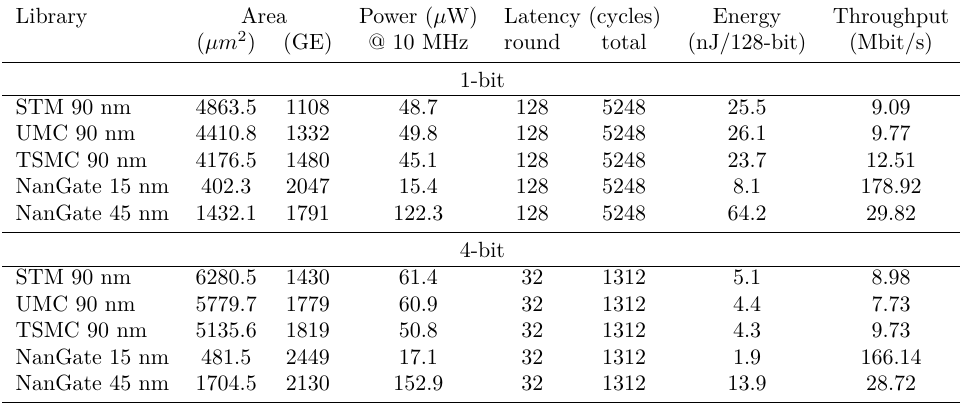
Table 11: Synthesis figures for 1-bit and 4-bit GIFT ∗ encryption-only